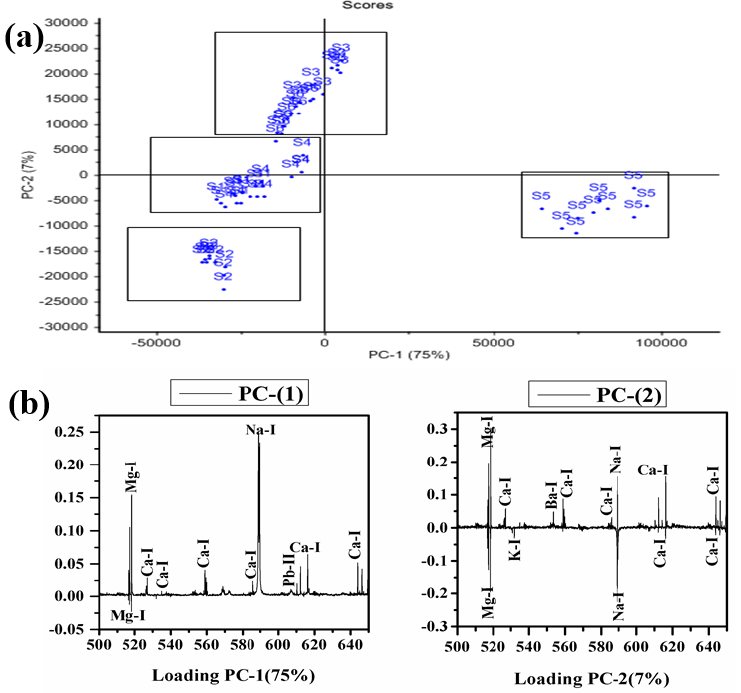
Figure 8. PCA score plot along with loading plot of PC1 and PC2 of all samples. ( a ) Score plot and ( b ) Loading plot. Table 4. Functional group observed in FTIR spectra of turmeric samples.